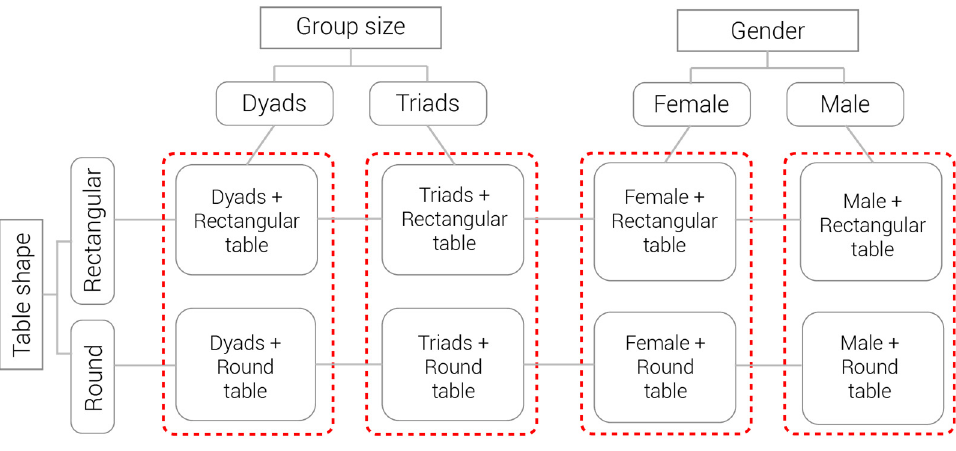
Figure 2. Four cases